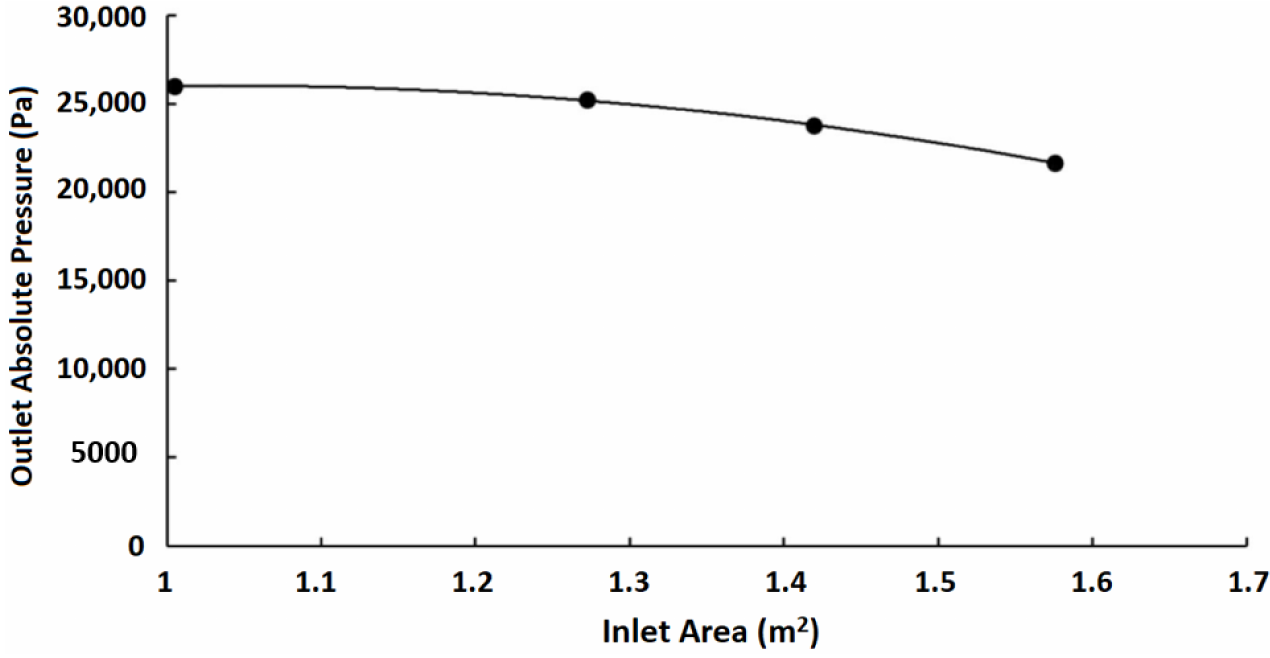
Figure 11. Outlet pressure variation with respect to the inlet